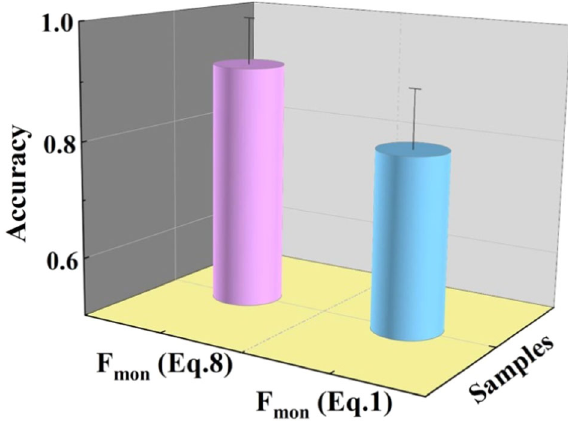
Fig. 5 Accuracy comparison of the grip strength under consider- ing the 3D contact area or not. When considering the 3D contact area, F mon (Eq. (8)), the accuracy of the grip strength calculated from Eq. (8), is higher than that of not considering the 3D contact area from Eq. (1), namely F mon (Eq. (1)). Accuracy improves 11.18% after considering 3D contact area. Details in Fig. S12 in supporting